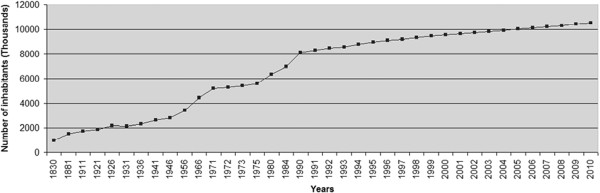
Tunisian population growth [[8],[9],[16]].